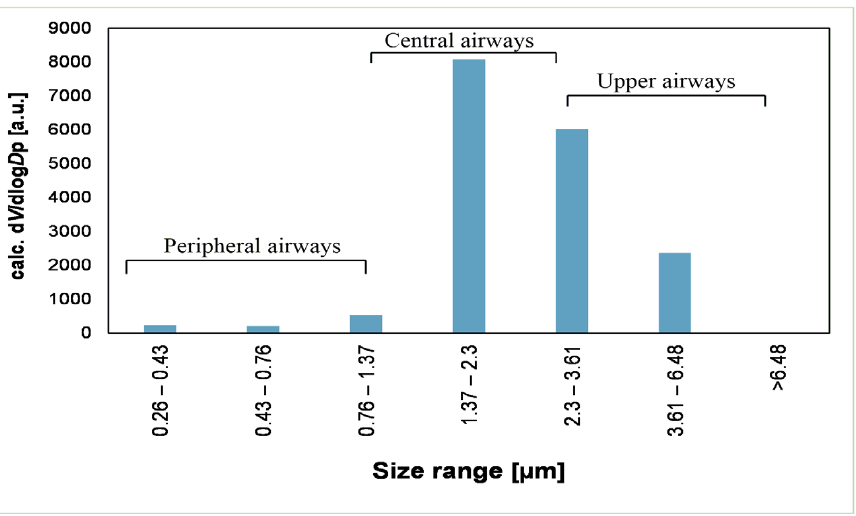
Figure 4. Stability of the nanosuspensions with the relative change in particle size (nm) and poly- dispersity index (PDI) at 15-day-intervals over one month. Results are expressed as mean ± S.D, performed in triplicate.